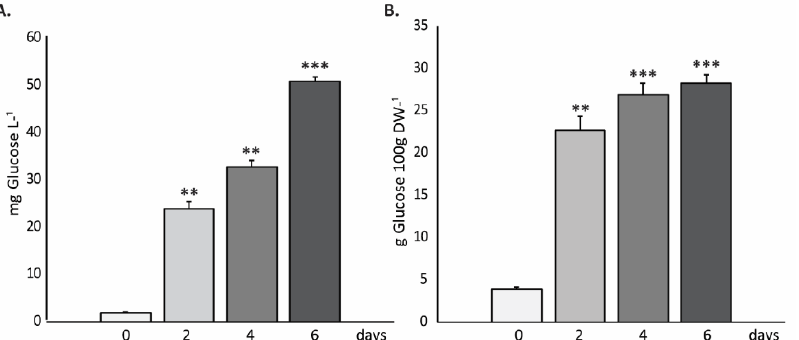
Figure 5. Total carbohydrate content of H. coffeaeformis cells. The graphics show the carbohydrates (expressed in mg of glucose∙L −1 ( A ) and also in g Glucose 100 g∙DW −1 ( B )) at day 0, and after 2, 4 and 6 days of growing in the photobioreactor. The graphics show an average of the obtained values ± standard deviation (n = 3). ** highly significant (p < 0.01); *** very highly significant differences (p < 0.001) between conditions, respectively.